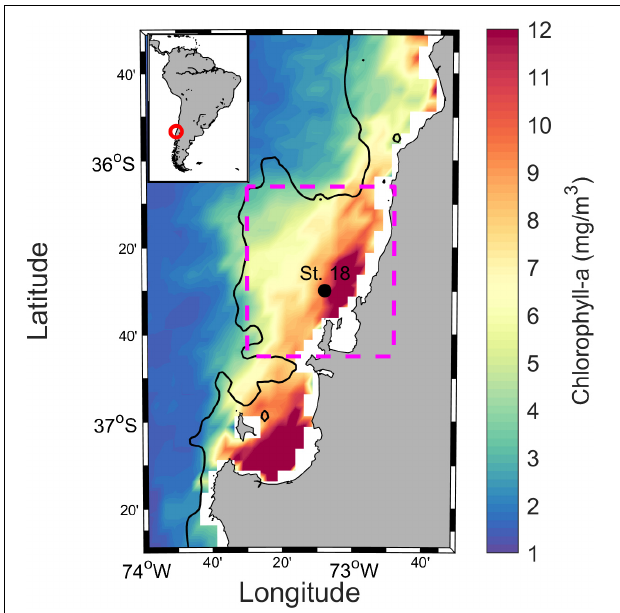
FIGURE 1 | The geographical location of the study site at Station 18, off Concepción in central Chile. Color scale represents the average chlorophyll- a concentration observed between November 2009 and January 2011. The black solid line shows the 200 m isobath and the magenta dashed square represents the area analyzed for Net Primary Production estimates. The map was generated using Ocean Data View (Schlitzer,